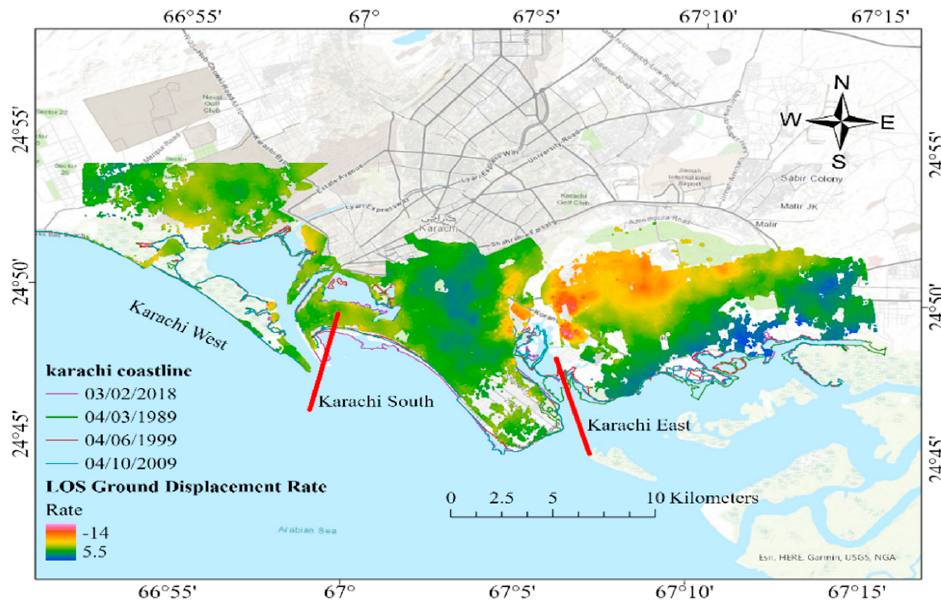
Figure 7. Evolution of Karachi’s coastline from 1989–2018, obtained from Landsat along with LOS ground displacement (2004–2010).